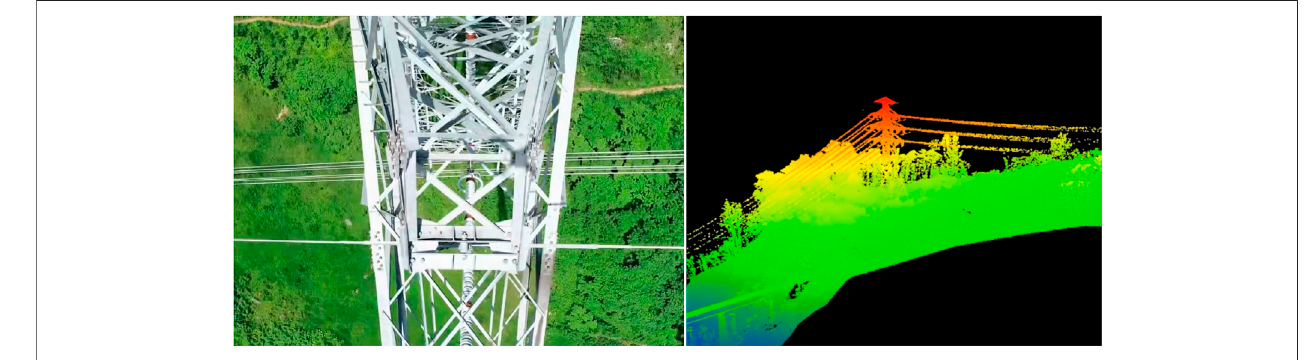
FIGURE 5 | Visible and infrared images.